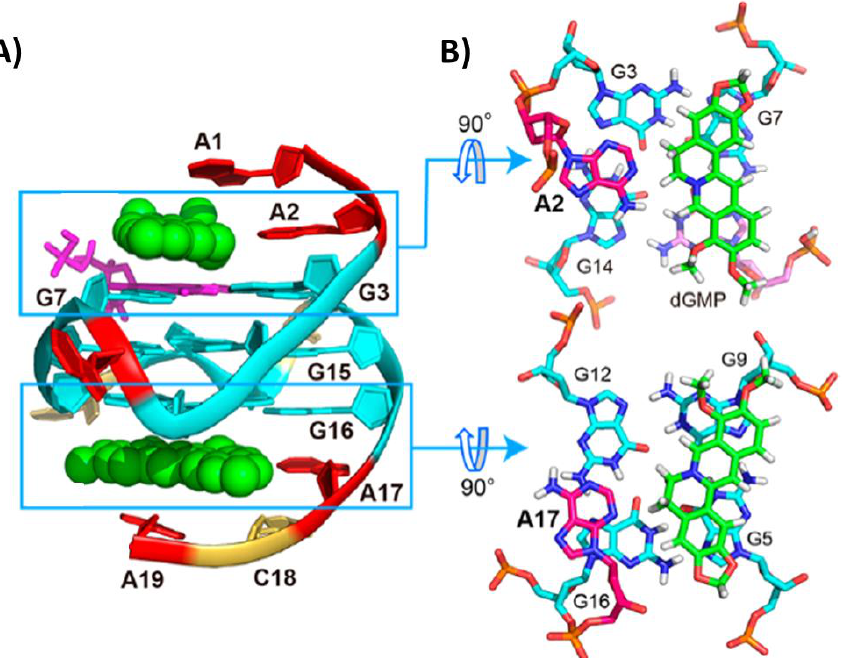
Figure 13. ( A ) NMR structure of the ternary complex formed by the unimolecular parallel G-quadruplex PDGFR- β of sequence d(AAGGGAGGGCGGCGGGACA), one dGMP molecule and berberine. Details of the berberine binding are highlighted in ( B ). Adapted with permission from ref. [96], Copyright 2021 American Chemical Society.